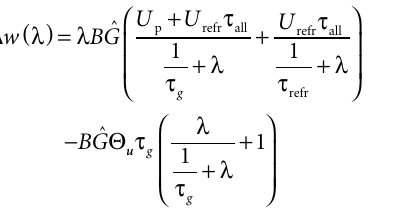
; (B) sweep of U ; (C) sweep of U u p refr